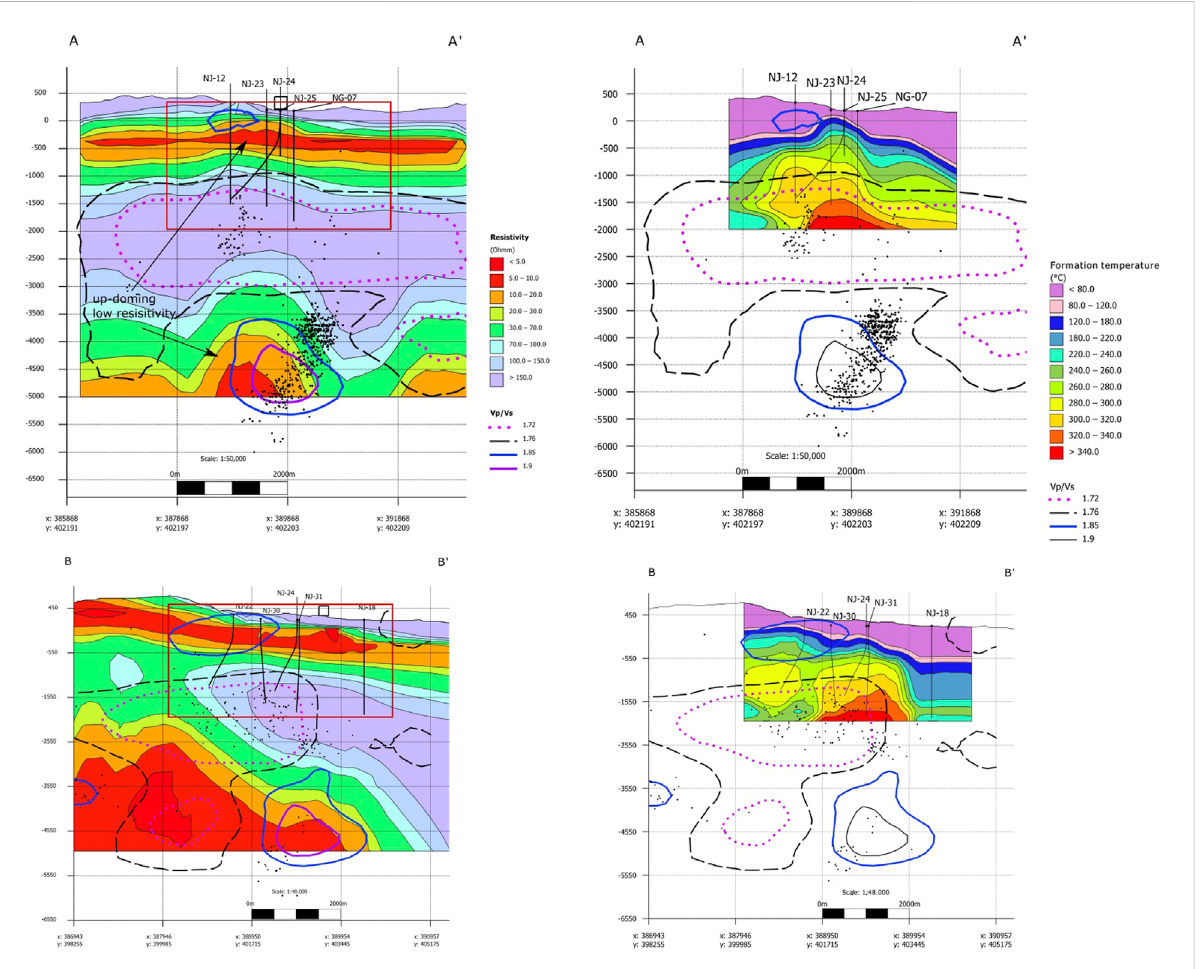
FIGURE 9 Cross-sections (A) A ′ and (B) B ′ (locationsaregivenonFigure 1).Earthquake ’ shypocenters areshown onallfour fi guresasblackdots[500 mto ratio. Left panel: Resistivity model (Vilhjálmsson et al., 2019); Right panel: each side for (A) A ′ and 250 m for (B) B ′ ] and contour lines for the v P v S Formation temperature (Gunnarsson et al., 2011). Well heads and trajectories at 300 m distance from each pro fi le have been added to the pro fi les. Nesjavellir power plant is marked with a black square. Red box on the left panel shows the extent of the temperature data on the right panel in relation to the resistivity